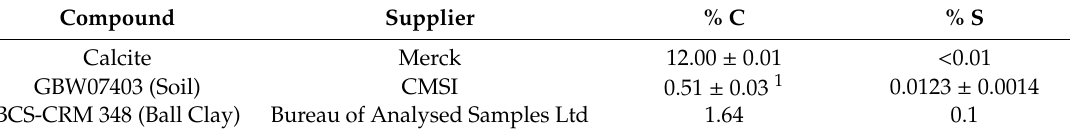
Table 2. Reference materials used in this study and suppliers of these materials.